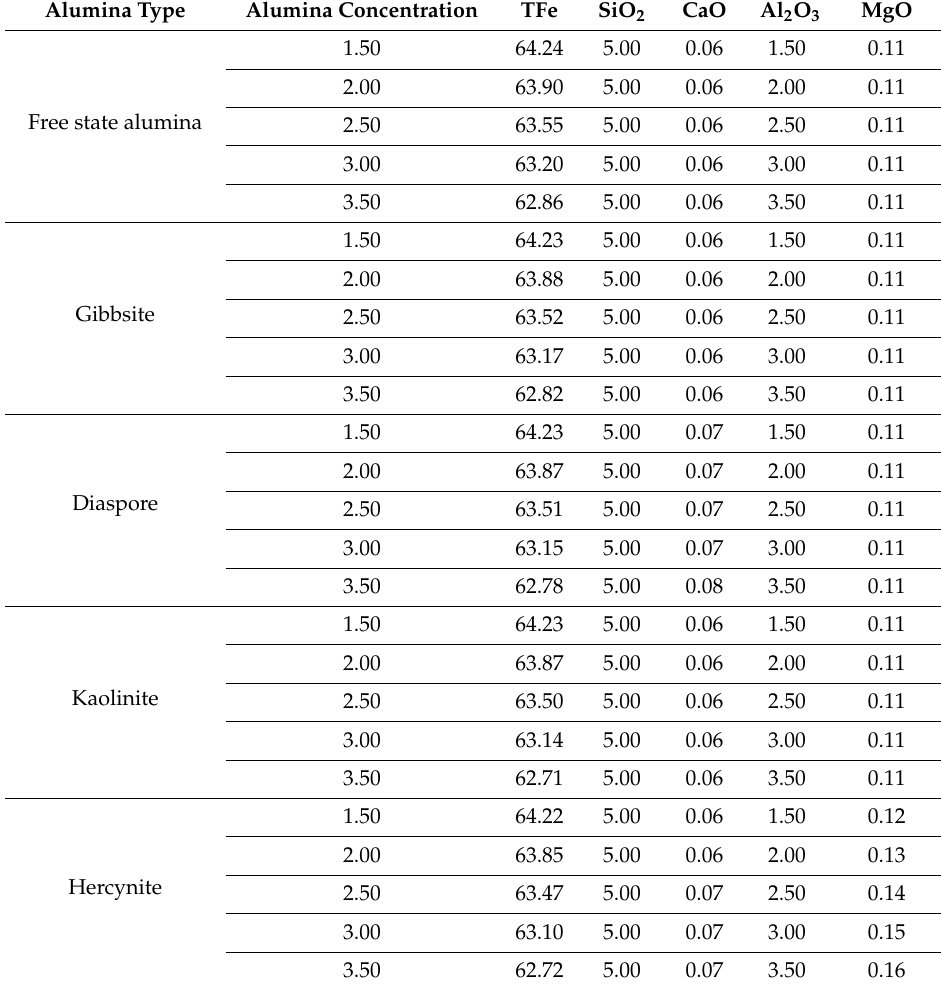
Table A3. Starting material compositions for the experiments of assimilability